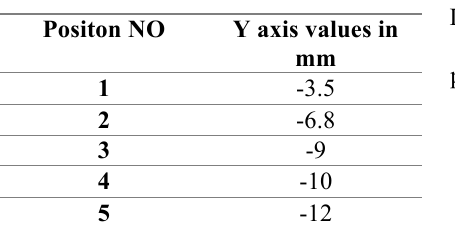
Figure 6: Simulated S characteristics of the UWB antenna 11 with two different ESRRs using HFSS.